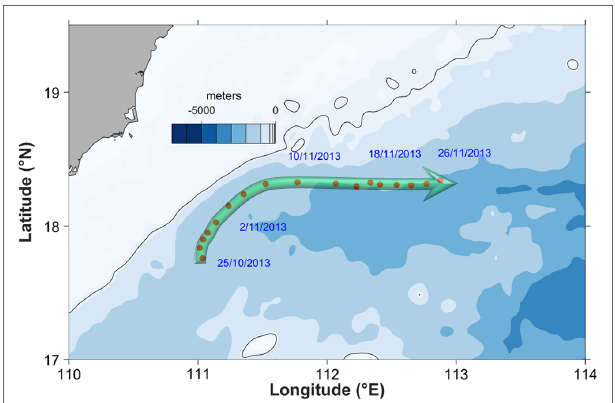
FIGURE 5 | The trajectory of the ARGO buoy (No-2901436) from October 25 to November 26, 2013, where the red cycles with dates show the locations and times (dd/mm/yy), respectively. The green arrow represents the slope undercurrent.